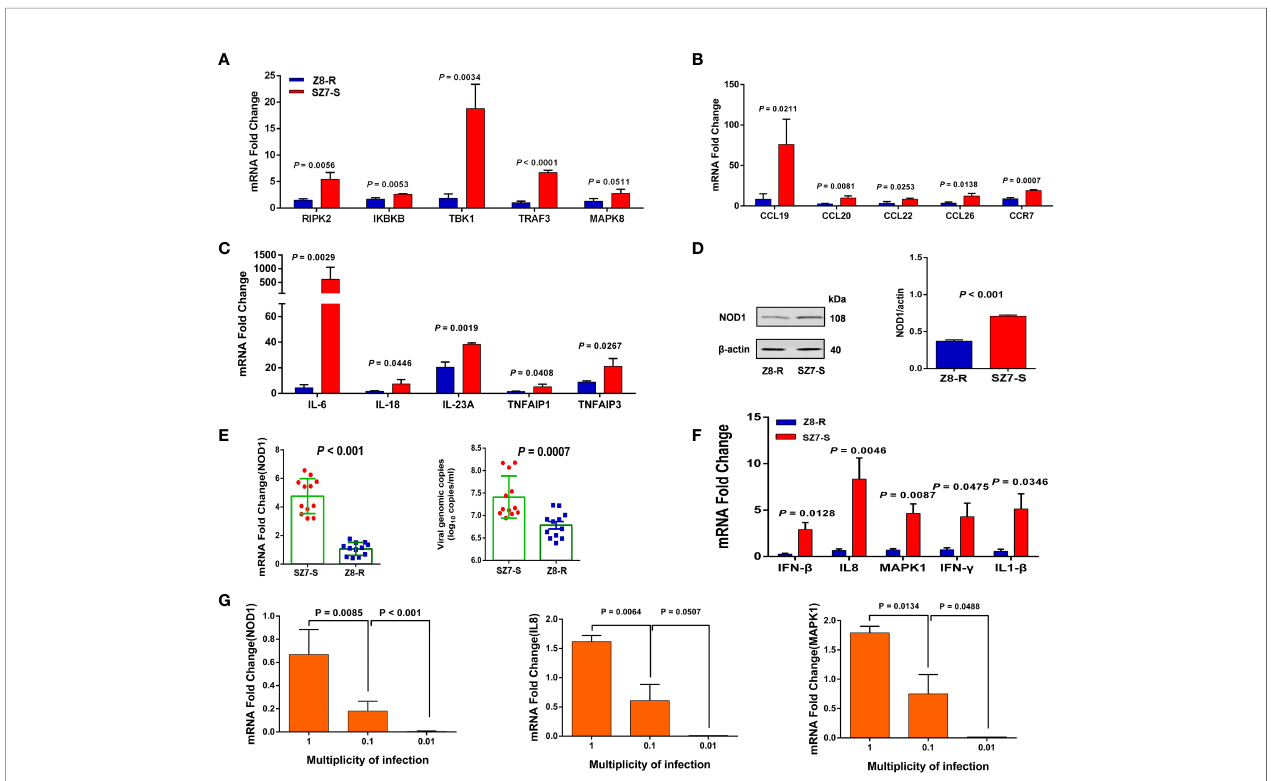
FIGURE 4 | The expression of NOD1 and downstream genes is activated by DHAV-3 infection. (A) RT - qPCR was used to quantify the expression of genes involved in NOD1 signaling pathways. (B) RT - qPCR was used to determine the expression of chemokines. (C) RT - qPCR quanti fi cation of the expression of in fl ammatory factors. (D) The protein expression levels of NOD1 in the livers of Z8-R and SZ7-S. Representative western blot (left panel) and quanti fi cation results from three independent experiments (right panels). (E) RT-qPCR quanti fi cation of the expression of NOD1 and the genomic copy numbers of DHAV-3 in primary liver cells from Z8-R (n = 9) and SZ7-S (n = 9). (F) RT - qPCR analysis of IL8, IFN- b , MAPK1, IFN- g , and IL1- b mRNAs in the liver cells of Z8-R and SZ7-S ducks. (G) The expression levels of NOD1, IL8 and MAPK1 at different multiplicities of infection. Primary liver cells of SZ7-S ducks were used in this